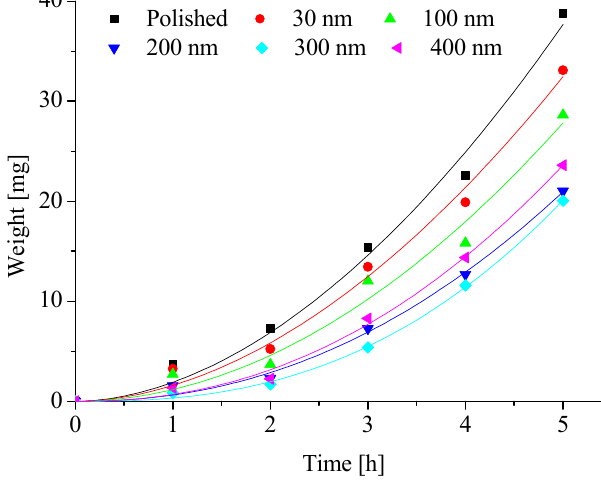
Figure 23. Testing value polynomial model regression fitting at T = − 10 °C, φ = 60%.